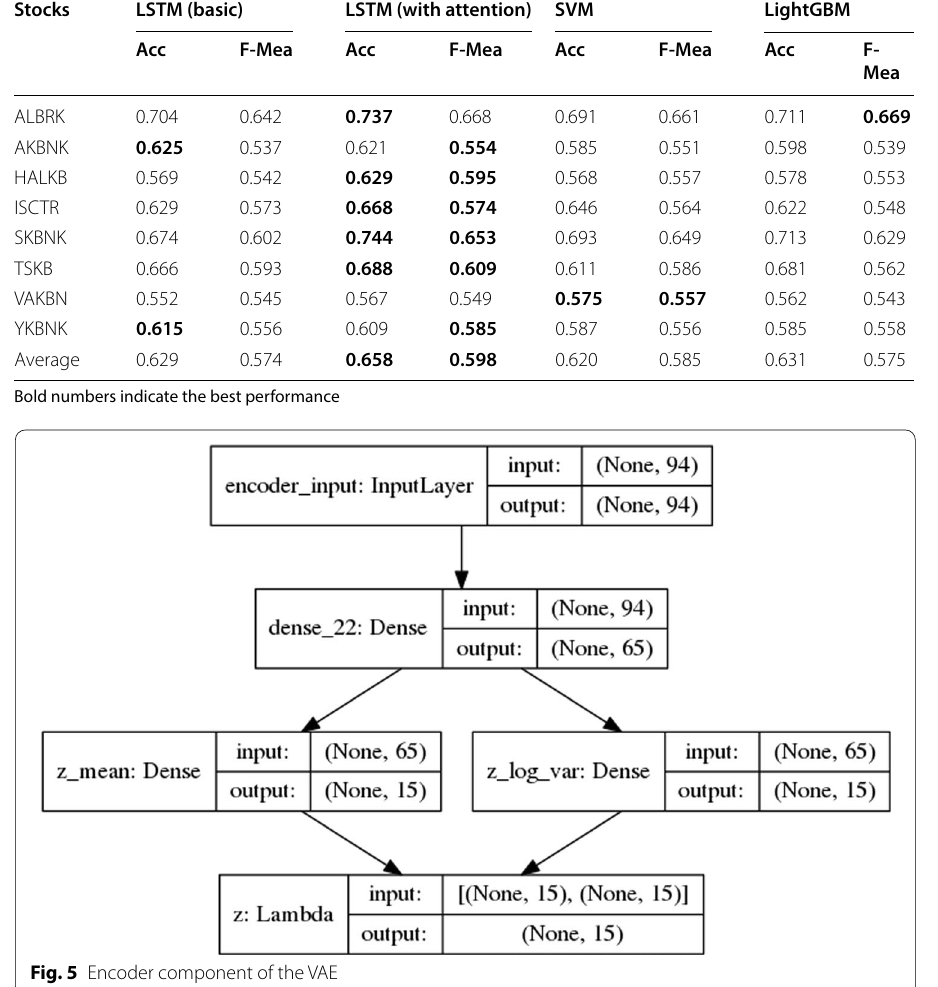
Table 7 Classification results using own stock features Stocks